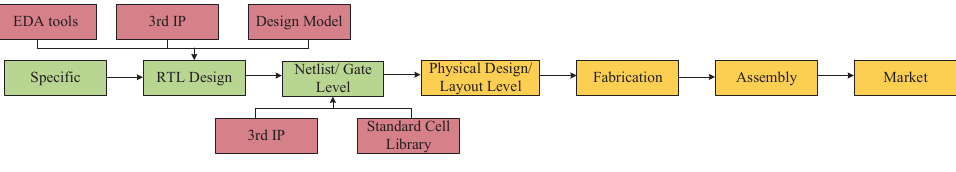
Figure 1. Design flow of